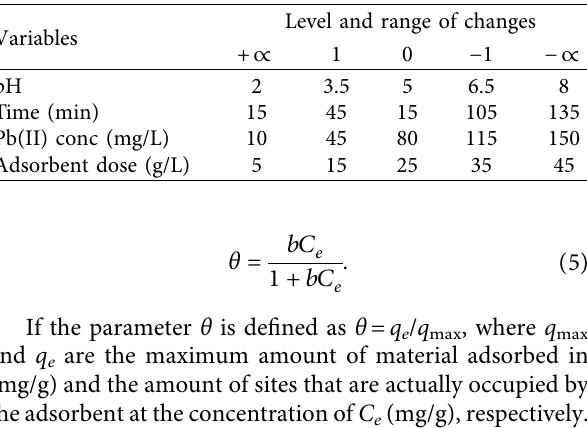
Table 1: Level and range of parameter